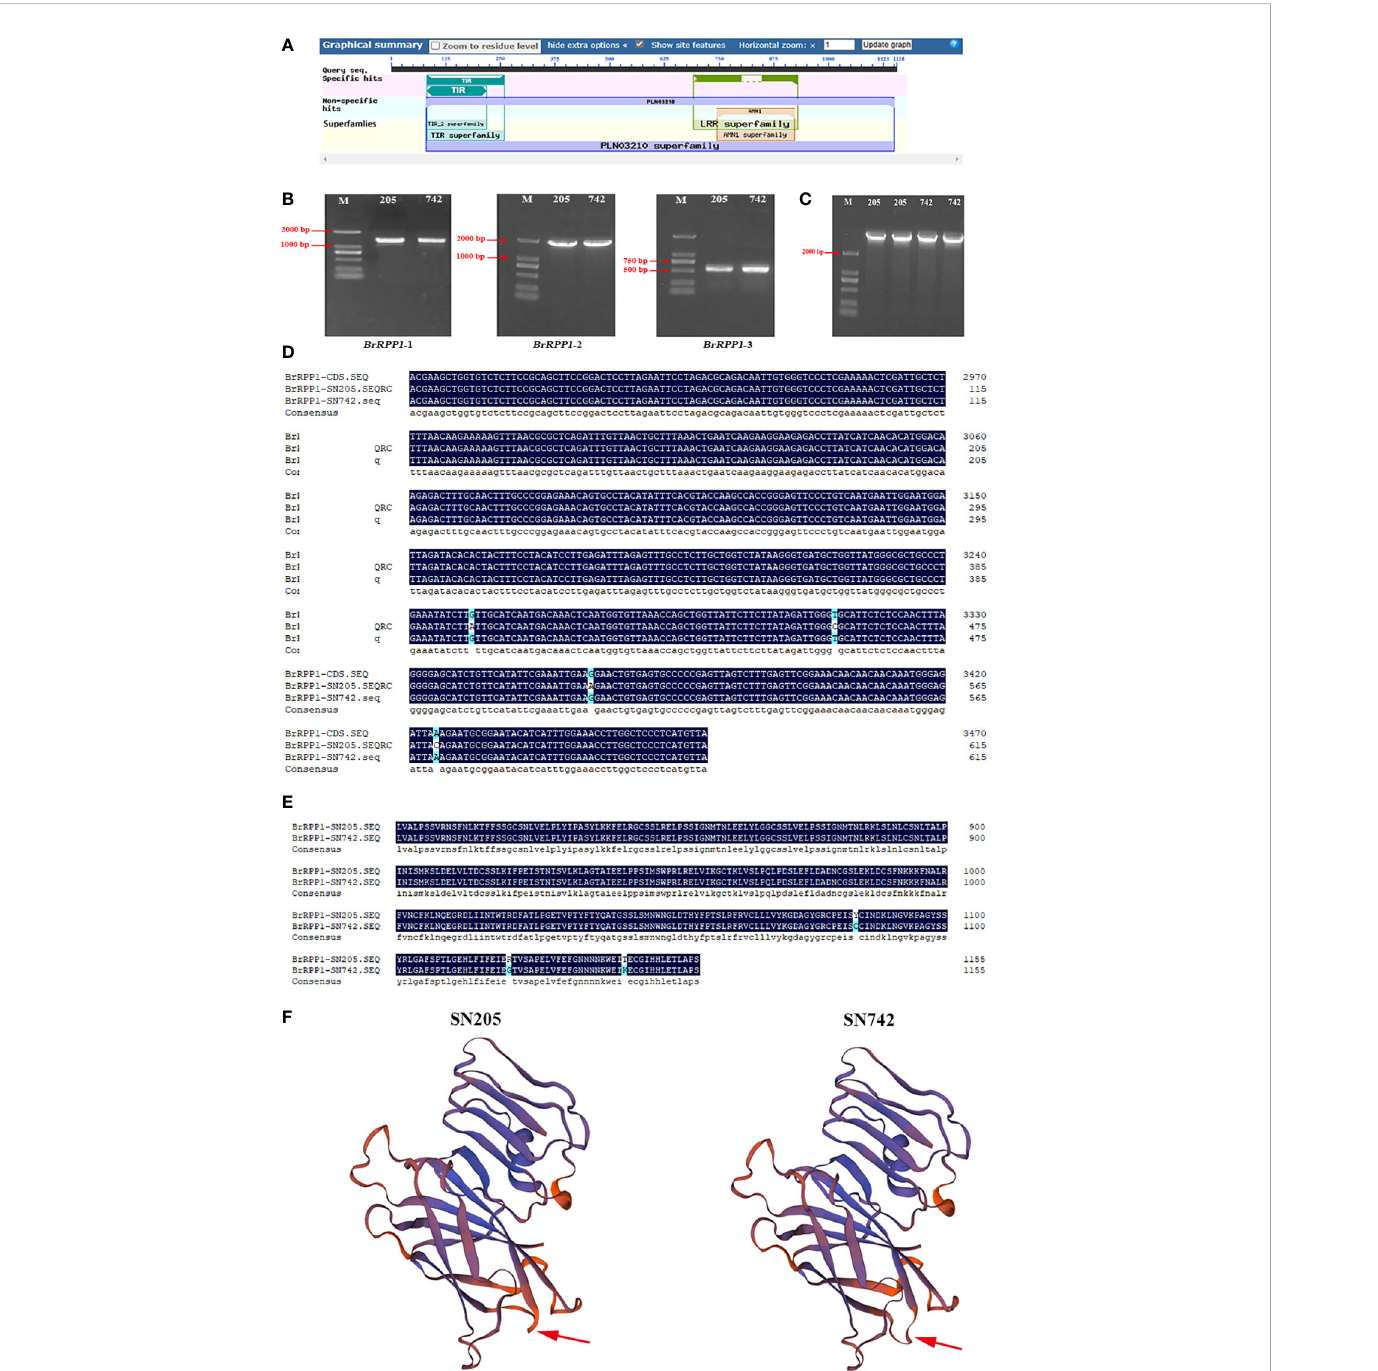
FIGURE 1 Acquisition and analysis of BrRPP1 gene sequence. (A) Conservative domain prediction of BrRPP1 . (B) BrRPP1 fragment ampli fi ed from ‘ SN205 ’ and ‘ SN742 ’ with three segmented primers BrRPP1-1, BrRPP1-2 and BrRPP1-3 . (C) The cDNA full-length of BrRPP1 in ‘ SN205 ’ and ‘ SN742 ’ . (D) cDNA sequence alignment of BrRPP1 in different regions between ‘ SN205 ’ and ‘ SN742 ’ . (E) Amino acid sequences alignment of BrRPP1 in different regions between ‘ SN205 ’ and ‘ SN742 ’ . (F) Protein structure prediction of BrRPP1 in ‘ SN205 ’ and ‘ SN742 ’ . The arrow points to the different